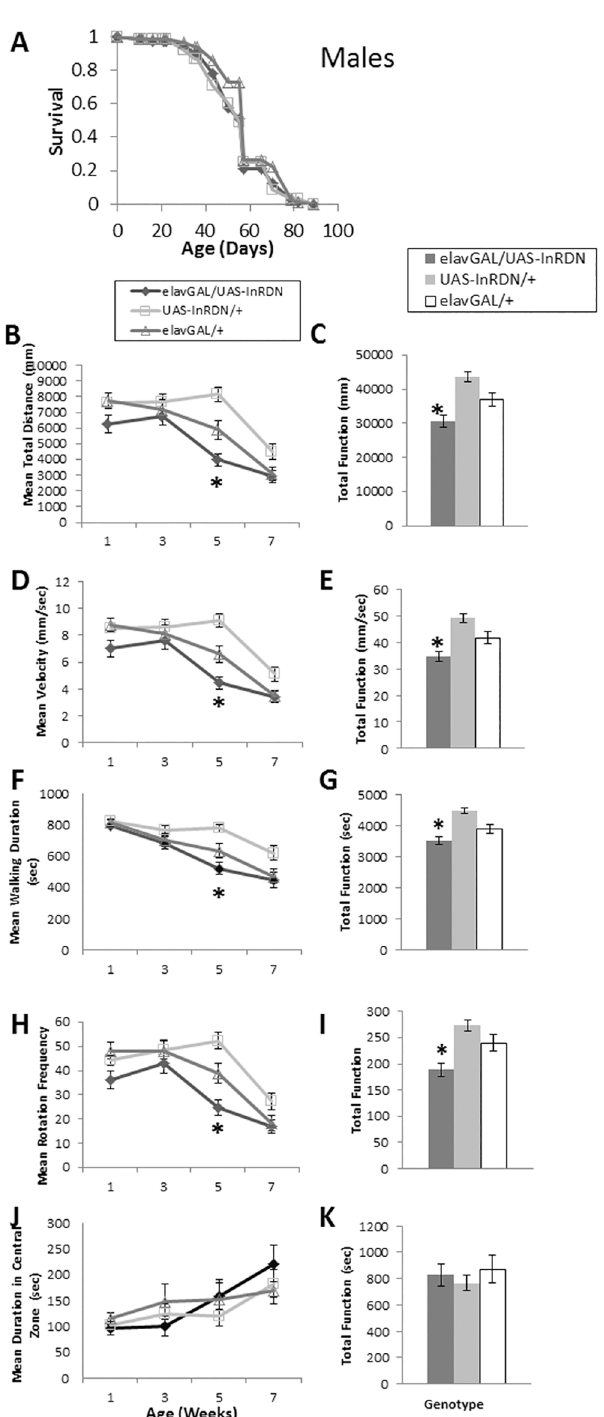
Fig 5. Exploratory walking senescence in elavGAL4/UAS-InR DN male flies. (A) Survival of elavGAL4/ UAS-InR DN male flies compared to elavGAL4/+ and UAS-InR DN /+ controls. Survival curves were compared using nonparametric log rank tests and p values calculated. Median lifespans and sample sizes were: elavGAL4/UAS-InR DN = 56 days, N = 105; elavGAL4/+ = 53 days, N = 89; and UAS-InR DN /+ = 56 days, N = 95. elavGAL4/UAS-InR DN showed no difference in survival compared to both controls (Log Rank test, p > 0.05). ( B-K ) Exploratory walking senescence for a cohort of male flies of the indicated genotypes run in parallel with the survival experiment shown in (A). Data are shown as mean value for each parameter ±